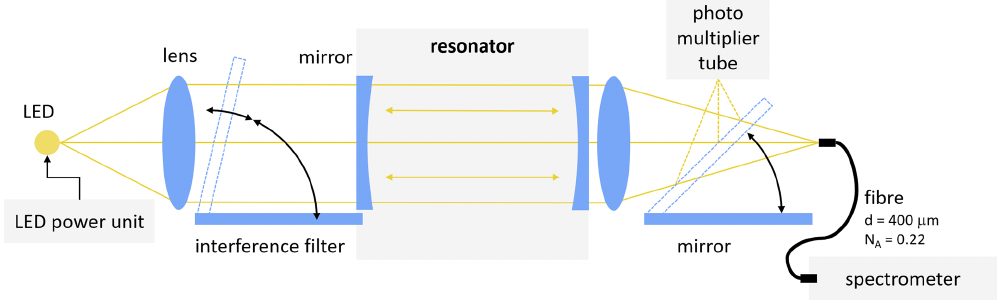
Figure 2. Schematic of the CE-DOAS instrument assembly fitted for NB-CRD calibration. For spectrally resolved ring-down measurements, the interference filter can be driven into the light path under different angles. A mirror is used to deflect the beam into a photomultiplier tube.